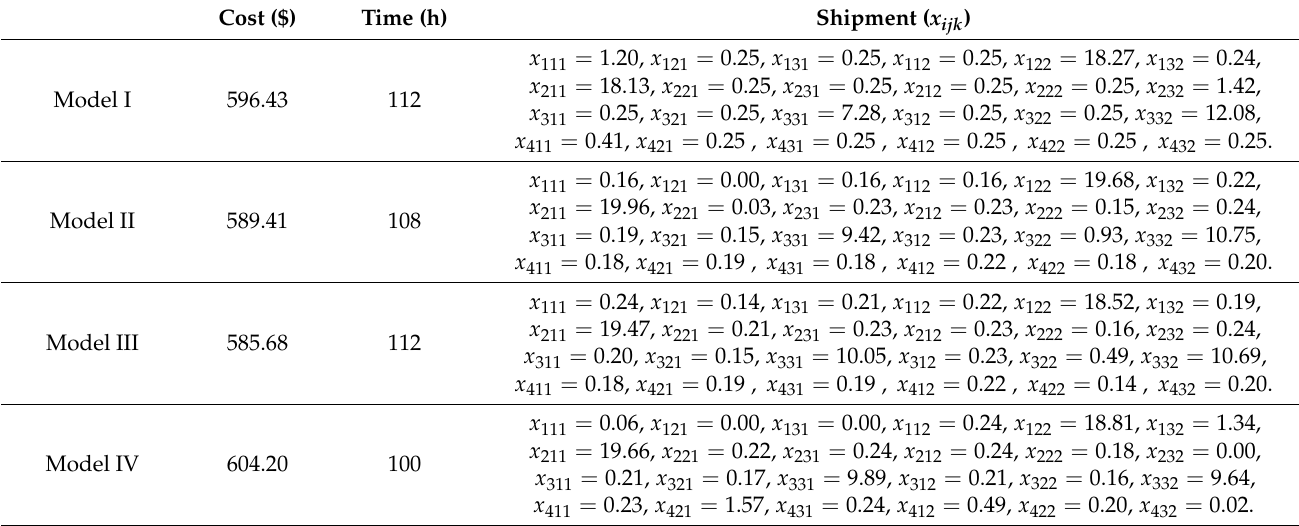
Table 5. Optimal solutions for four stochastic models using the FGP approach.